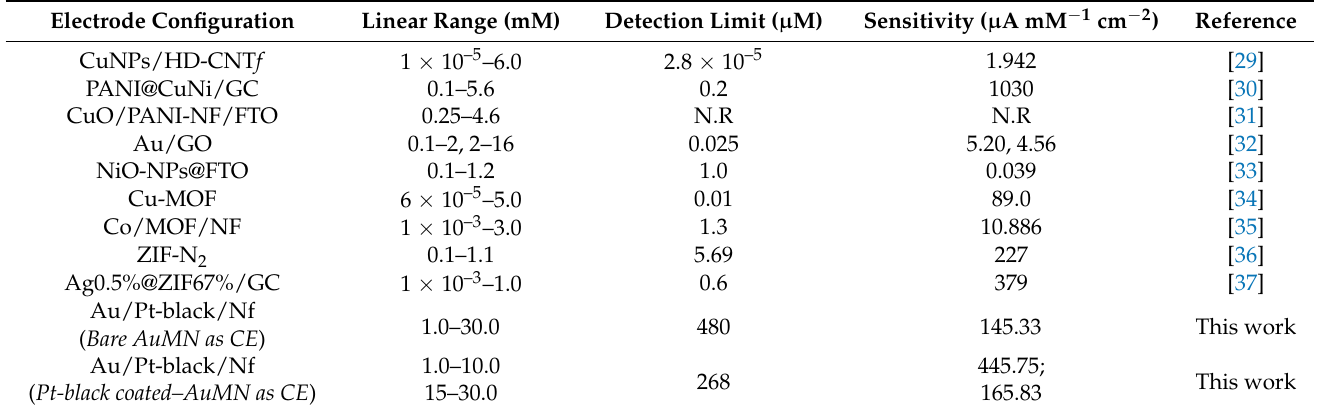
Figure 6. ( a ) Constant potential amperometric current response curves ( i vs. t ) for AuMN/Pt-black/Nf electrode array measured using the fabricated wireless non-invasive CGM system at a fixed external applied potential of +0.12 V vs. AgCl MN and bare AuMN as counter electrode in a background electrolyte of 100 mM PBS with successive step-wise addition of glucose from 1 mM → 40 mM; ( b ) the linear fitting curves for the current responses measured with the correlation co-efficient values (R 2 ) and linear regression equations. The measured data are presented as the average of three independent experiments (n = 3) with the range represented as standard error. Table 1. Comparison of the electrochemical sensor performance characteristics recorded using the wireless device with the previous reports.